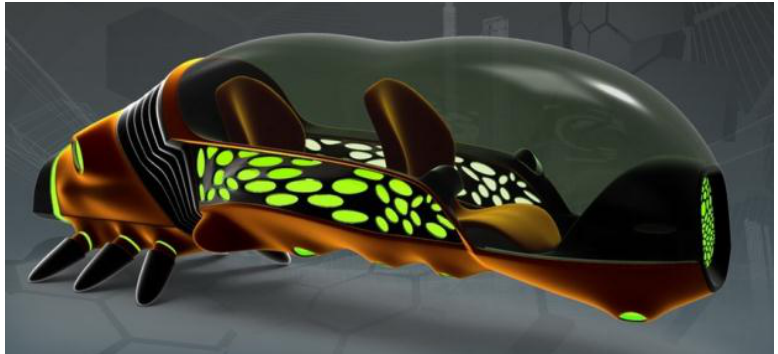
Figure 1. The BioThink Futuristic Vehicle for Mega-Cities: An image to inspire and frame the context of this paper as an open-ended contemplation of the future of personal transportation. Image credit: M. Ghezel